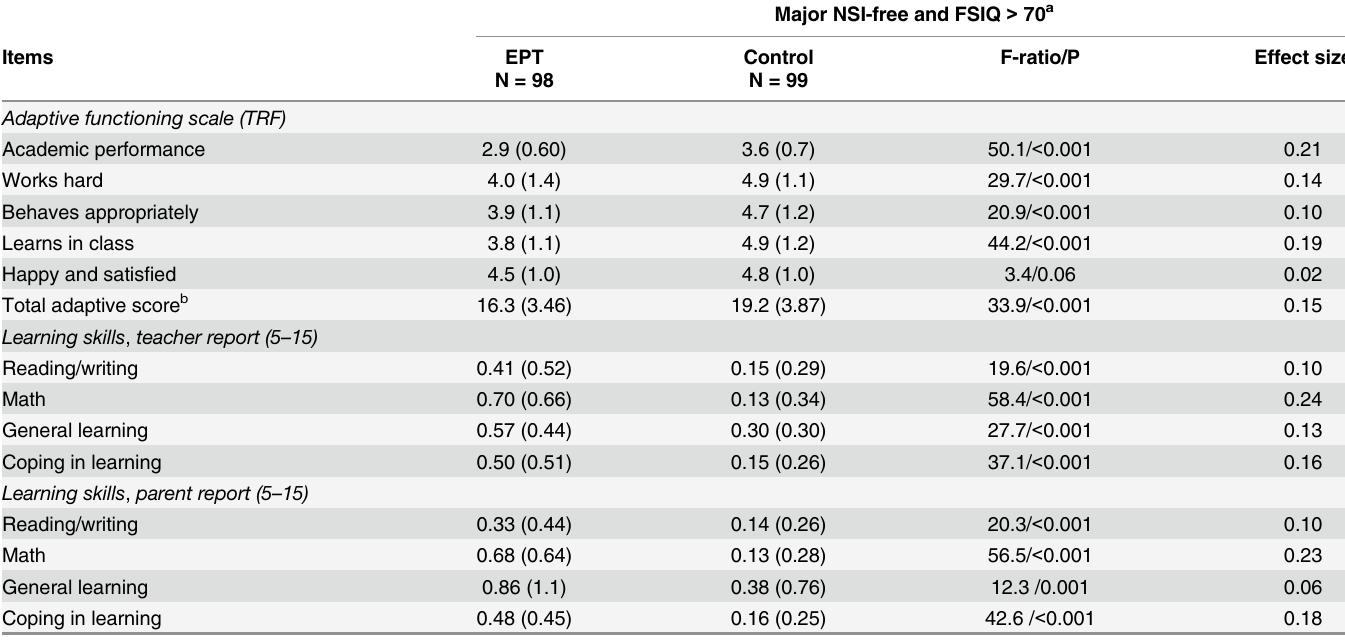
Table 5. Mean scores for adaptive functioning, academic performance and learning skills, as assessed by teacher and parent reports, in each group without major NSI and with FSIQ > 70.